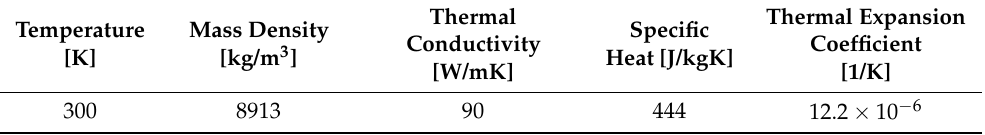
Table 7. Physical properties of the electrodeposited nickel as reported in [24].